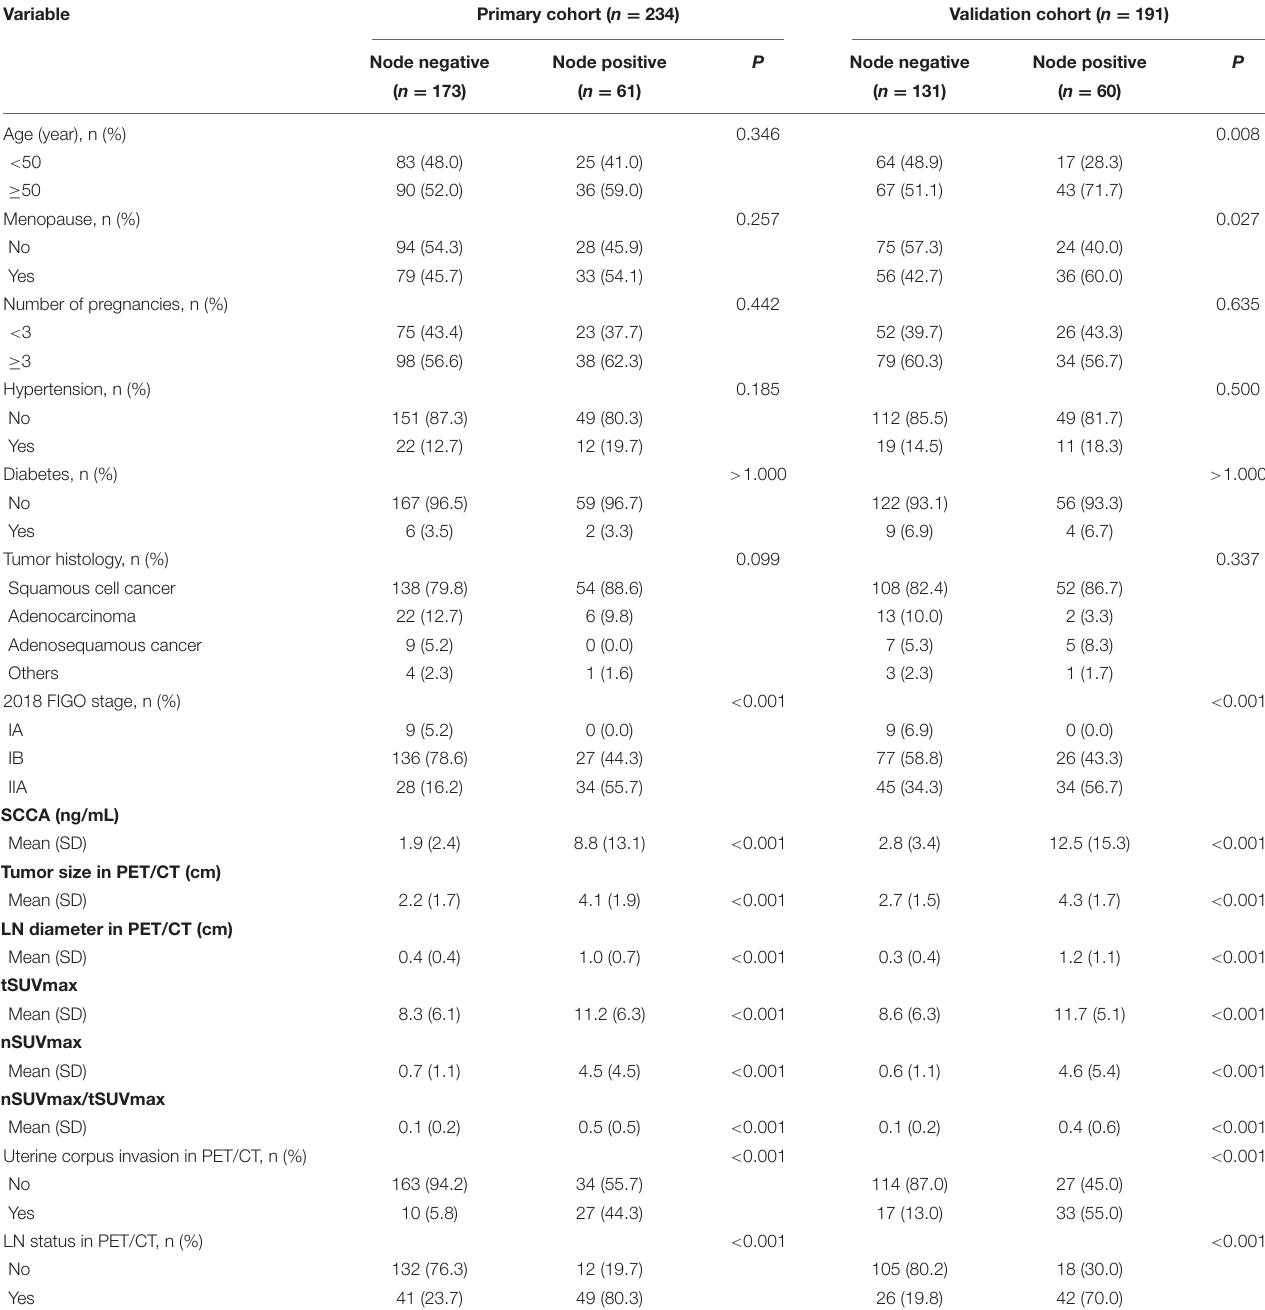
TABLE 1 | Patient characteristics and univariate analysis of the risk of lymph node metastasis.